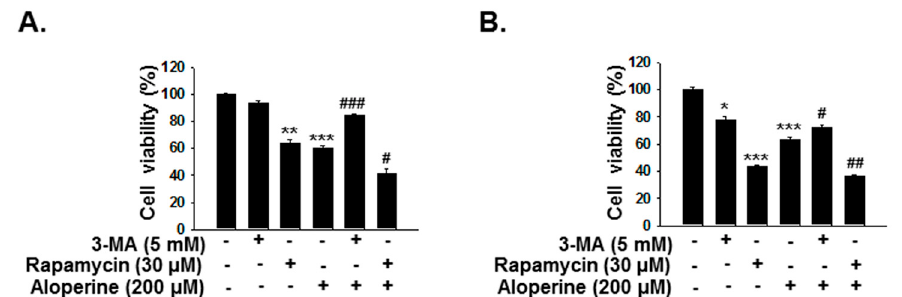
Figure9. Modulationofautophagyinhumanthyroidcancercellsa ff ectsaloperine-mediatedcytotoxicity. ( A ) KMH-2, and ( B ) IHH-4 cells were incubated with aloperine, rapamycin, 3-MA alone, or combination treatment, and their viabilities were determined after 24 h post-treatment using the CCK-8 assay. Cells treated with DMSO were used as a negative control, and all groups were normalized with the control group. The results are expressed as mean ± SD of three independent